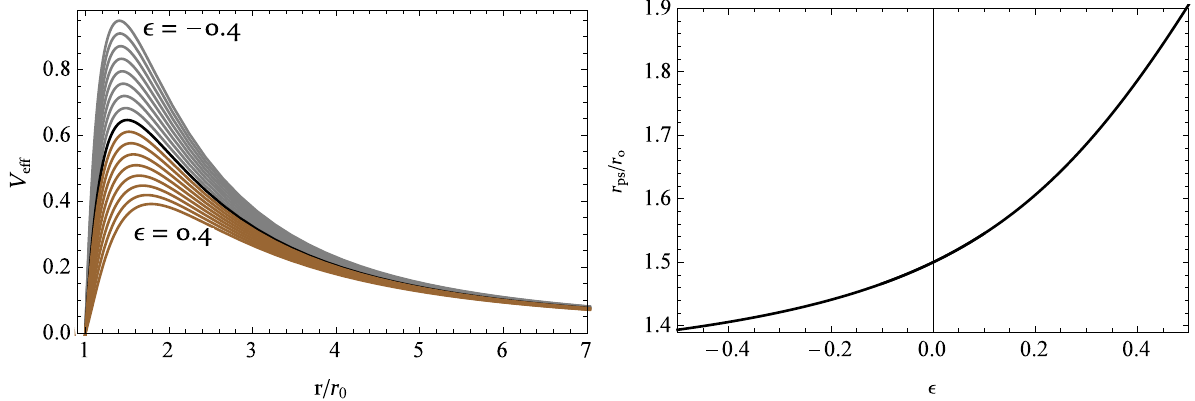
Figure 1. Left panel: Radial profile of the effective potential of photon for the parameter (cid:101) in the range [ − 0.4,0.4 ] with 0.05 steps. Where gray, black, and brown curves correspond to (cid:101) < 0, (cid:101) = 0, and (cid:101) > 0 cases, respectively. Right panel: a location of maximum of the effective potential as a function of (cid:101)